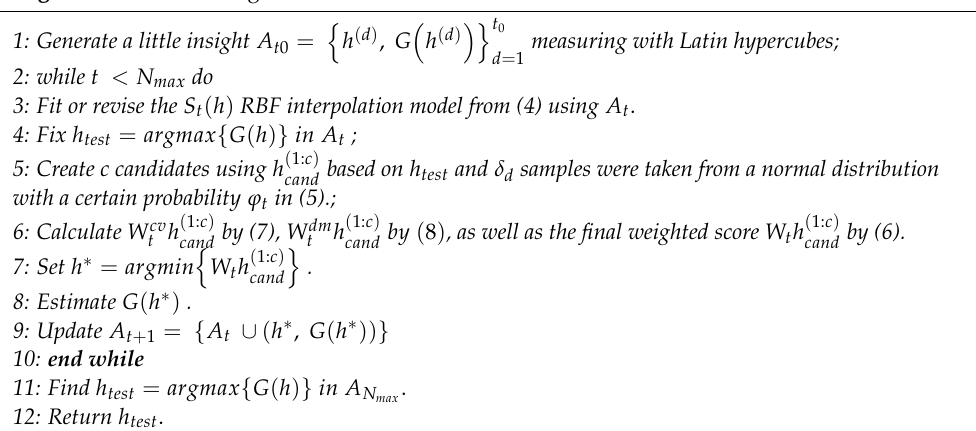
Algorithm 1: HORD